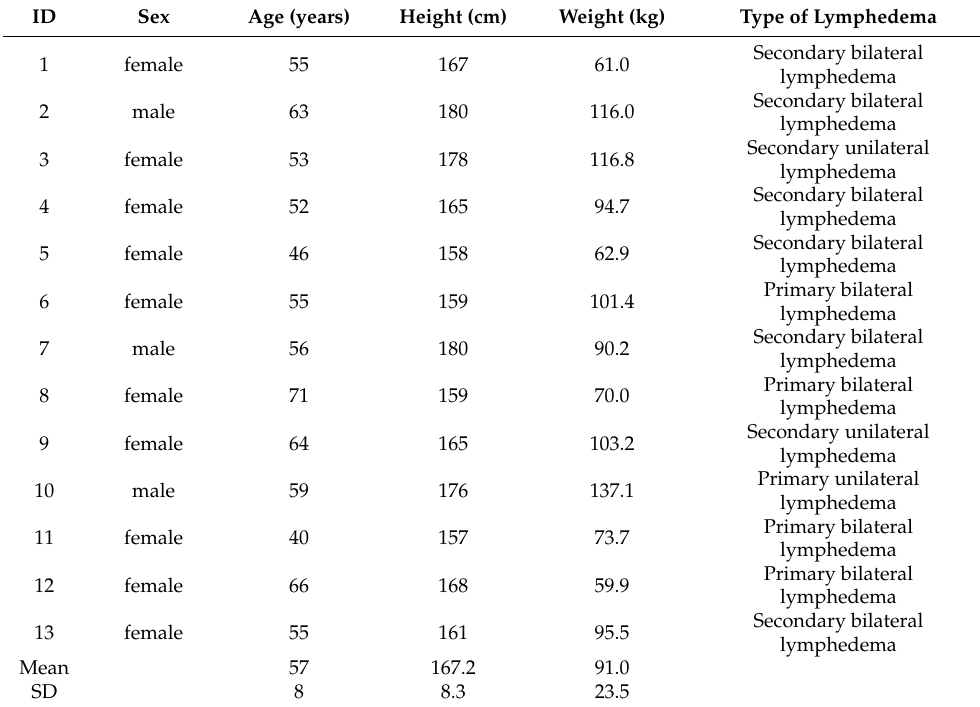
Table 1. Patients’ demographic details.